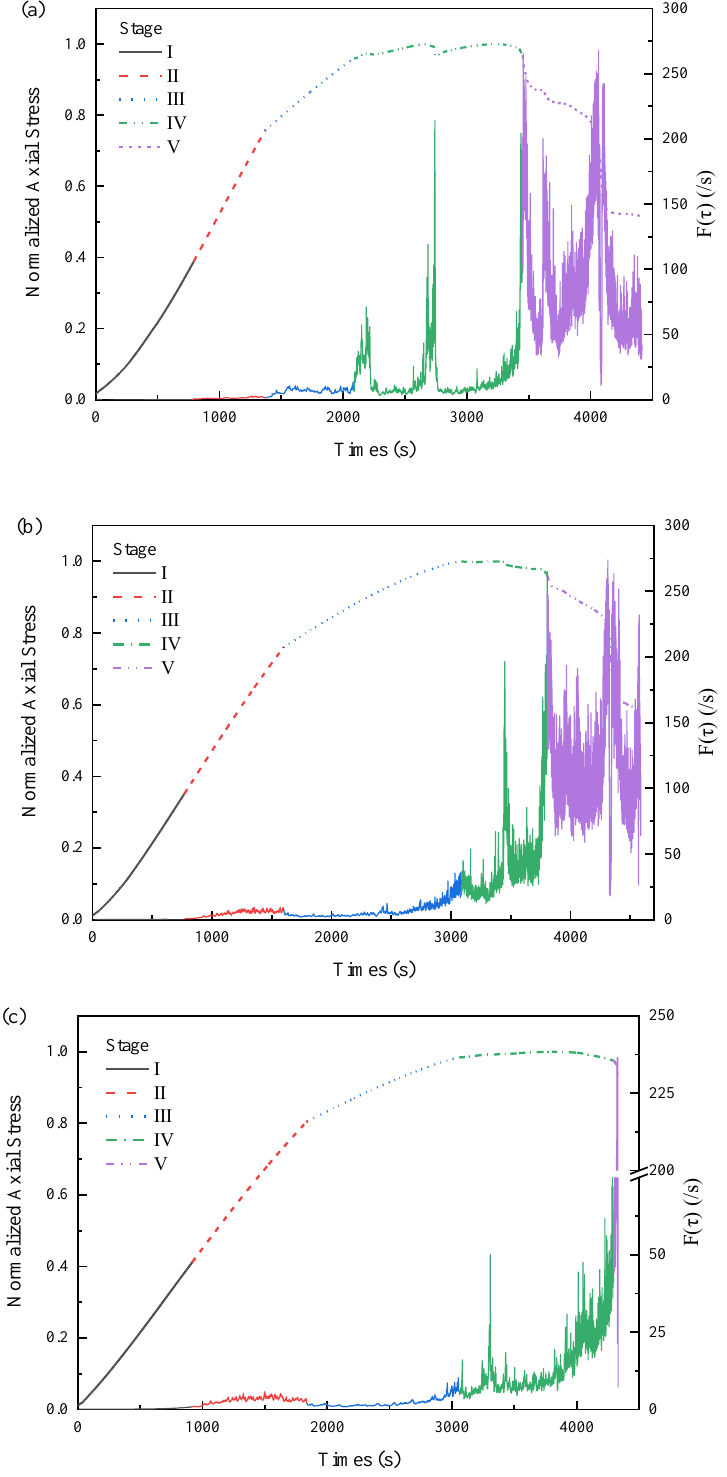
Figure 4. Stress –strain F(τ) evolution curves of granites. ( a ) A1, ( b ) B1, ( c ) C1. For sample A1, the value of the event interval function is extremely low and the curve is close to the horizontal axis within 0 – 2087 s, implying less AE activity. According to Z. mary pores or shear slip on the primary failure